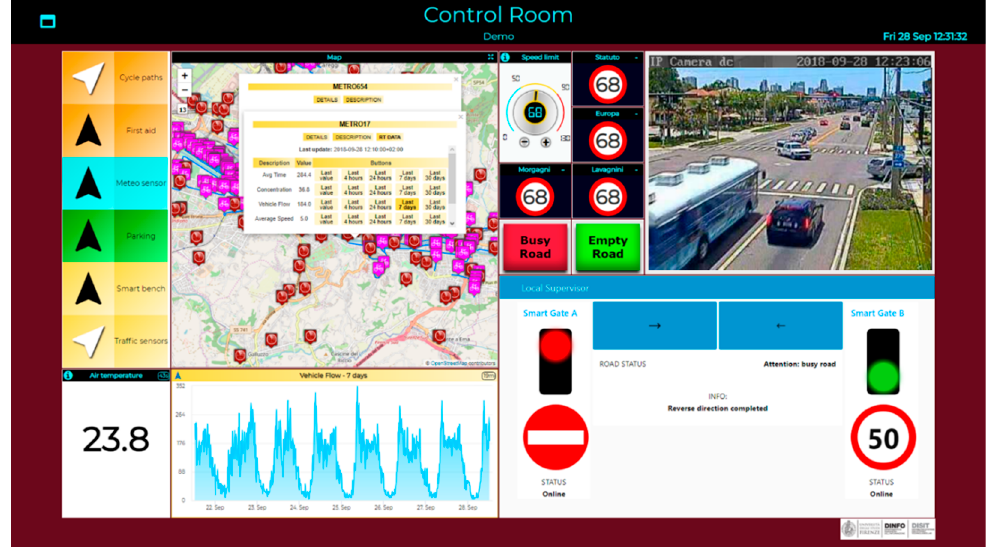
Figure 13. Flow that realizes the logic of the smart gate. The upper part is the one that receives the status and changes it if the ACK exchange is successful. The lower part is the one that checks if the connection is always active between the local supervisor and the smart